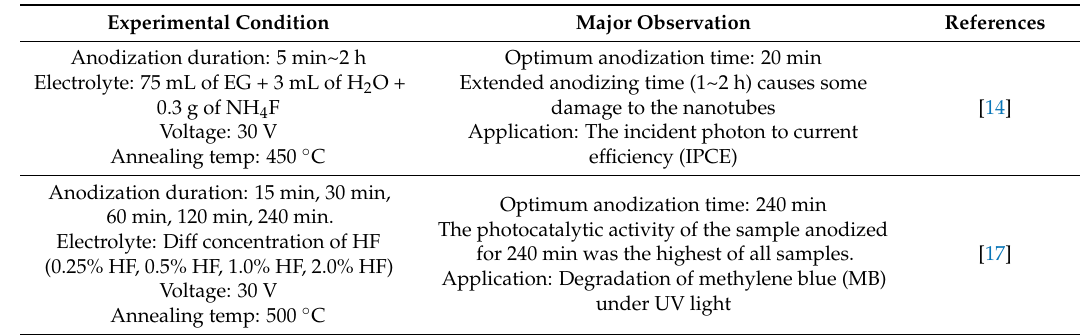
Table 1. Past research on anodization duration